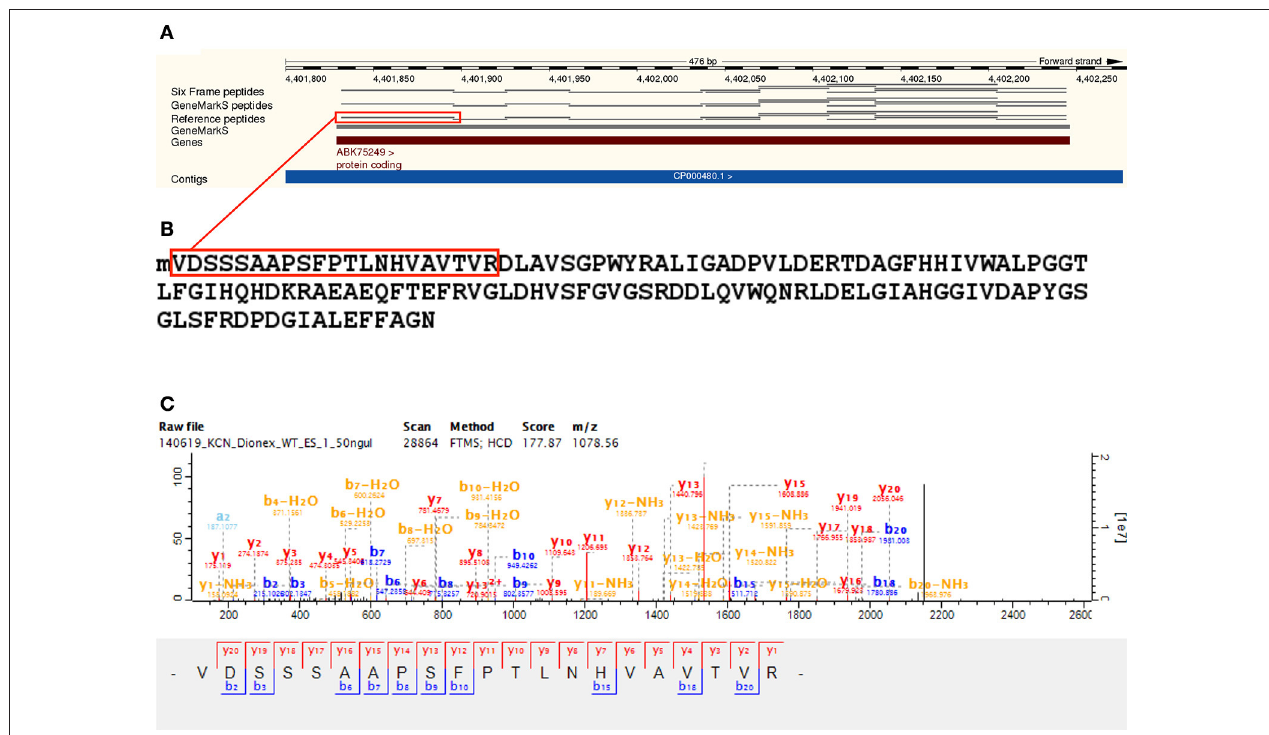
FIGURE 3 | Reference protein gene model validation — A0R0A1 . A validation of the gene model of the Reference protein A0R0A1 (Glyoxalase/bleomycin resistance protein/dioxygenase). This is an unreviewed predicted entry associated with dioxygenase activity (GO molecular function), of length of 138. Panel (A) illustrates validation of the gene model at the peptide level visualized on the Ensembl genome browser, with a sequence coverage of 99.28% from 13 peptides and a total of 152 MS/MS spectra identified in the Reference proteome database search. Panel (B) shows the identified translation start site (TSS) peptide, illustrating the cleavage of initiator methionine (N-Met) by methionine aminopeptidase (MAP) with Val as the penultimate amino acid. Panel (C) shows a representative MS/MS spectrum for the identified TSS peptide.